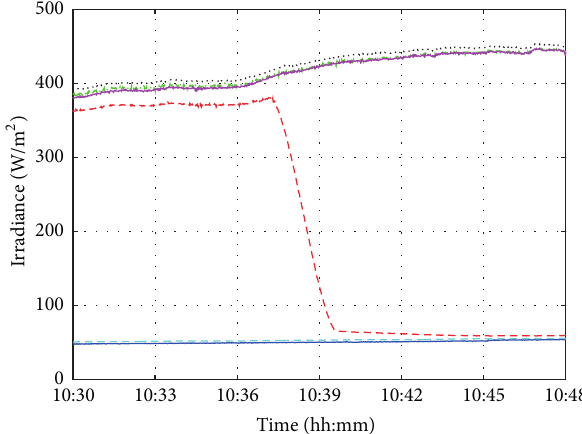
Figure 8: Irradiance profile received by String 2 on February 2nd, 2012, during a period of 18 minutes and measured with sensors from S9 to S14 (see Figure 2). Sensors from S9 to S14 correspond to the lines as follows: blue, red dashed, green dash-dotted, black dotted, magenta, and cyan dashed.